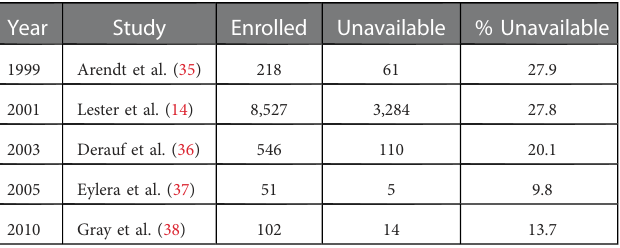
TABLE 1 Examples in the literature that demonstrate the extent of sample volume compliance using meconium for monitoring